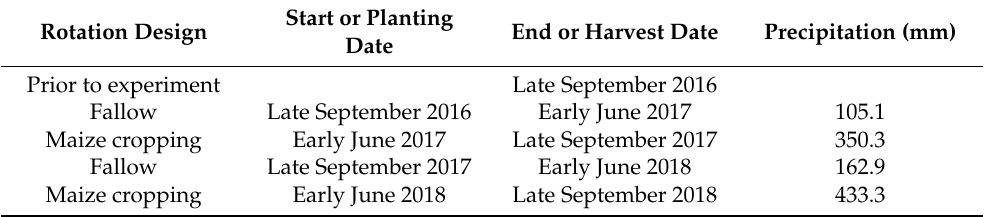
Table 2. Cropping schedules for the fallow–maize rotation system. The precipitation was calculated during the cropping season or fallow period, i.e., from maize planting to harvest and from maize harvest to the next year planting,